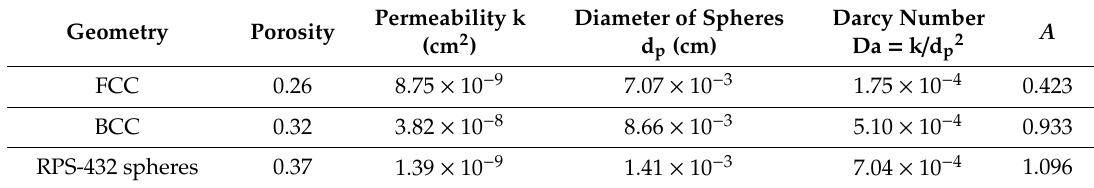
Table 6. Summary of properties of di ff erent packing types of porous media together with the A value.